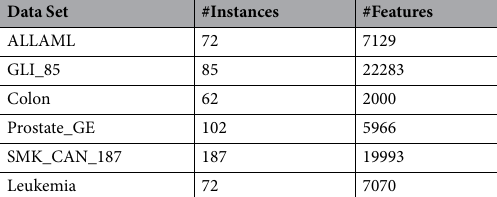
Figure 10 is an example of the EBWSA with 5 wolves and 100 iterations for the feature selection of the data- set Prostate_Ge – a high-dimensional bioinformatics dataset introduced in the next section. The first subfigure represents the wolves’ survival environment, which expresses the total weight of the Elitist wolves, whose fitness values are better than those of the wolves in the previous iteration. If this value is smaller than 0.5, the survival environment is considered to be bad, and the Elitist wolves will get more weight from their weaker counterparts. Because the search spaces of high-dimensional datasets are large, and the populations are small, most of the wolves have a difficult time finding a better solution. The next five subfigures describe the variations in each wolf’s (weight × population). If the weight is smaller than 1, then weight × population takes a value bigger or smaller than 1 to change the step size of each wolf. Therefore, these five subfigures indirectly present the step size changes of each wolf in 100 iterations.